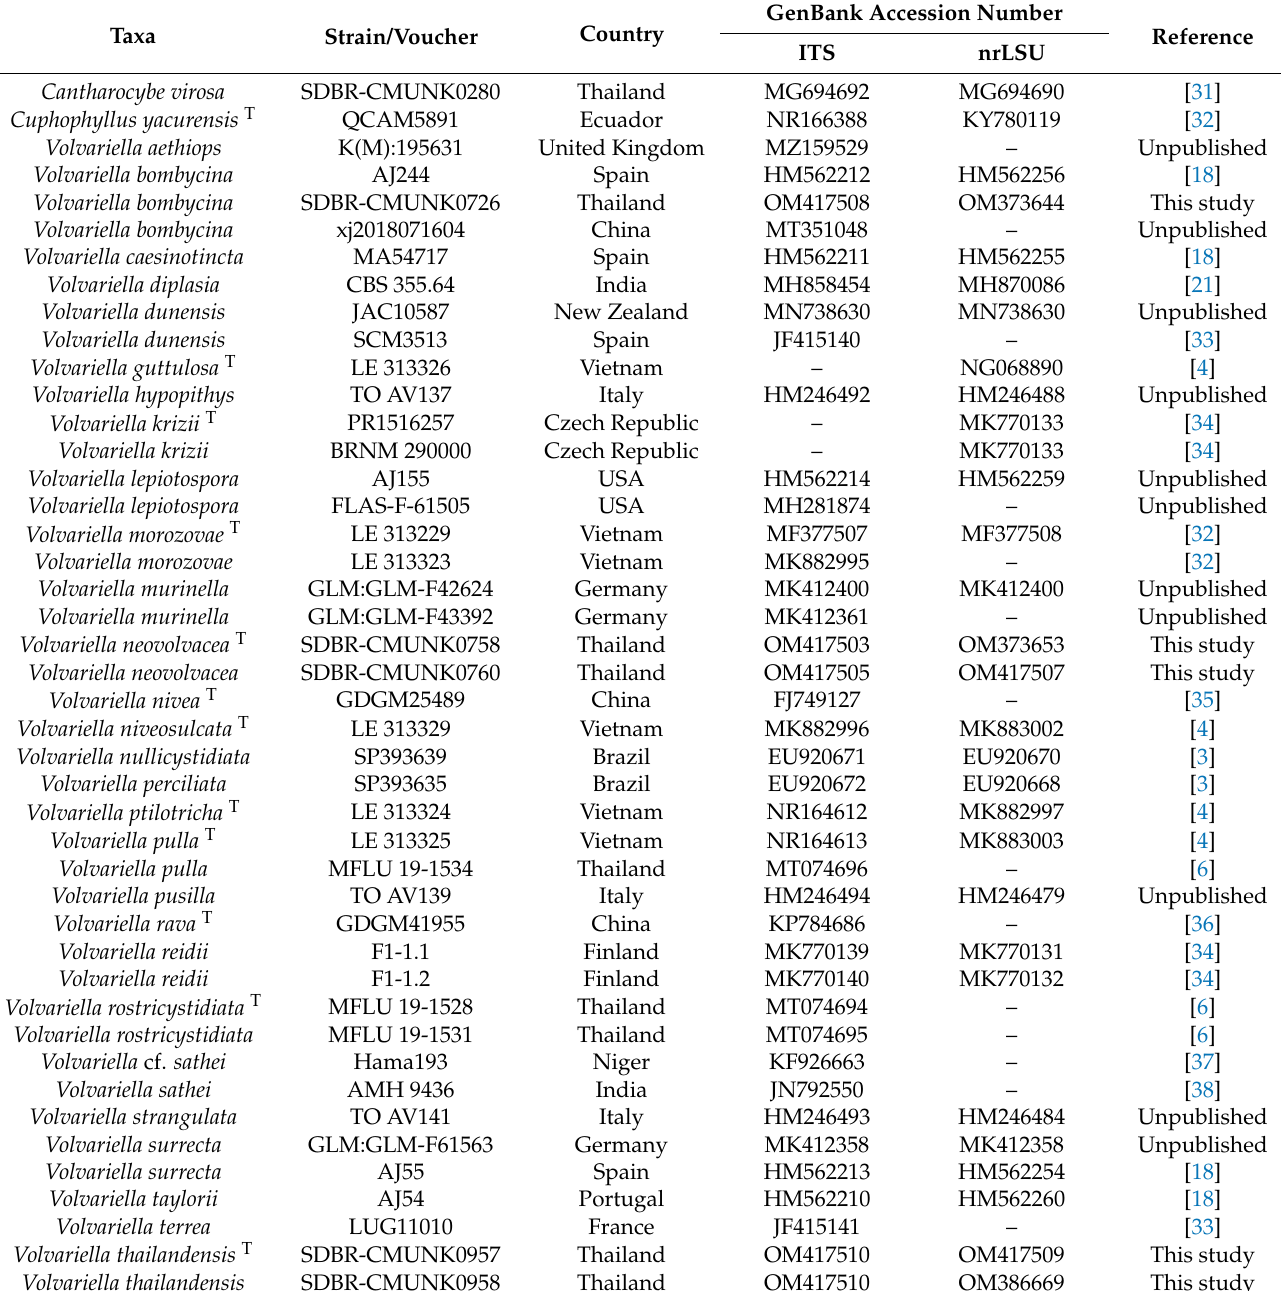
Table 1. Details of sequences used in the molecular phylogenetic